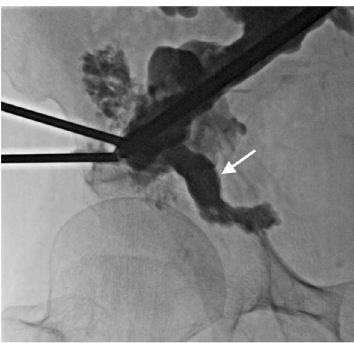
Figure 5. Anteroposterior fl uoroscopic view of the right acetabulum fi lled with PMMA cement (arrow) (third step of the procedure).